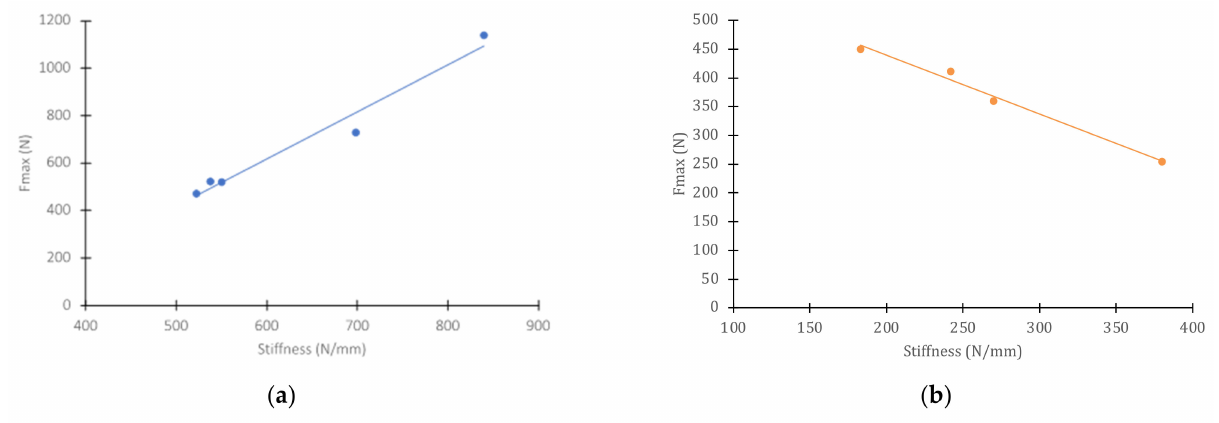
Figure 11. Linear correlation between strength and stiffness after cyclic impact: ( a ) dry material; ( b ) wet